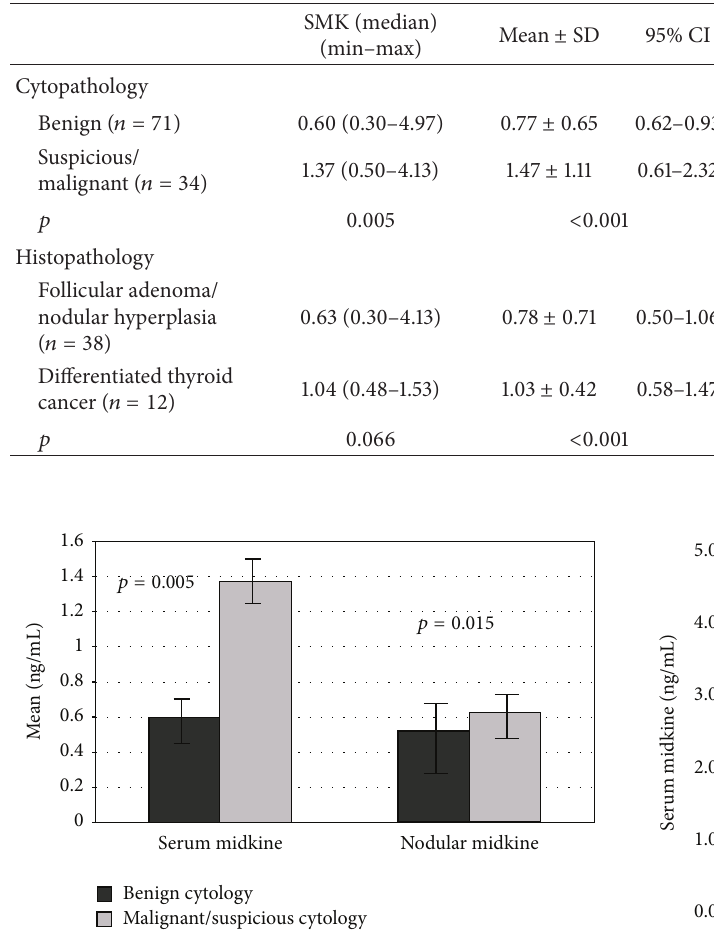
Figure 1: Serum and nodular MK levels evaluated according to FNA cytology.